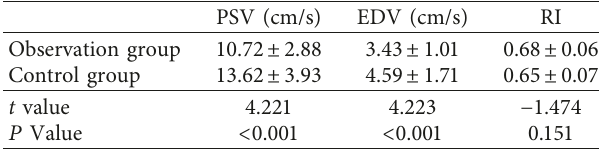
Table 5: Hemodynamic parameters of the